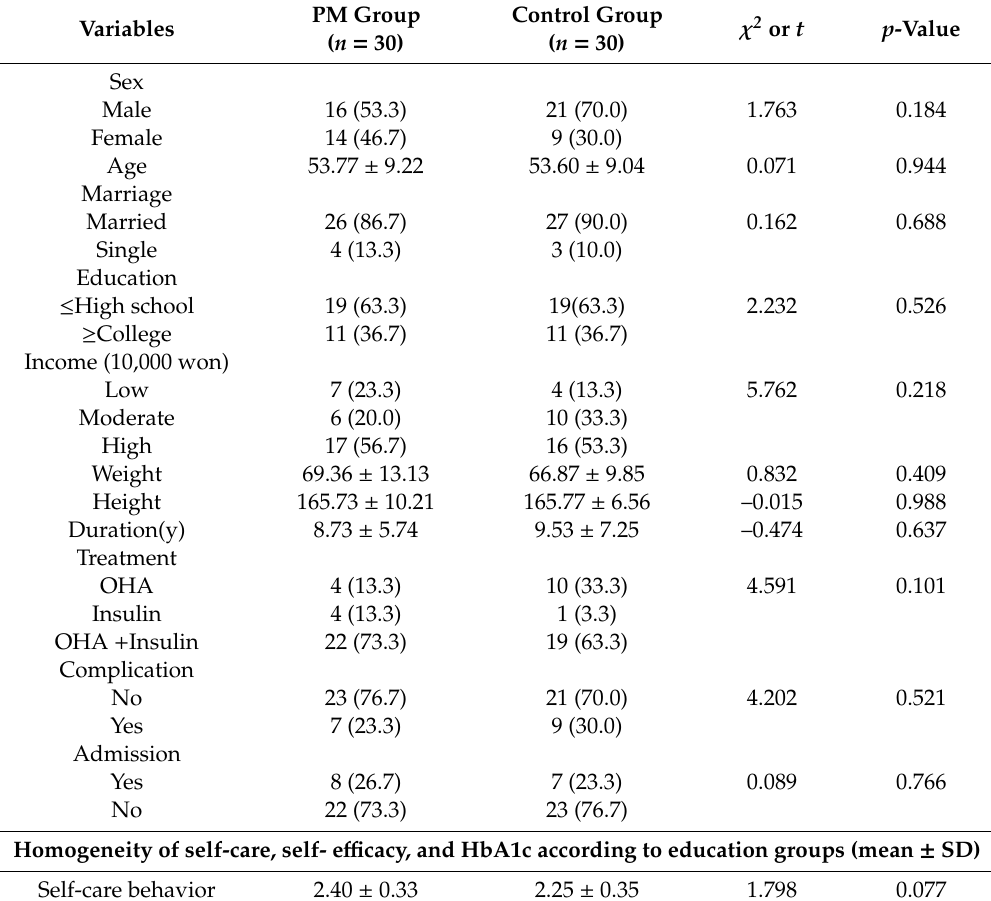
Table 1. General characteristics according to group.